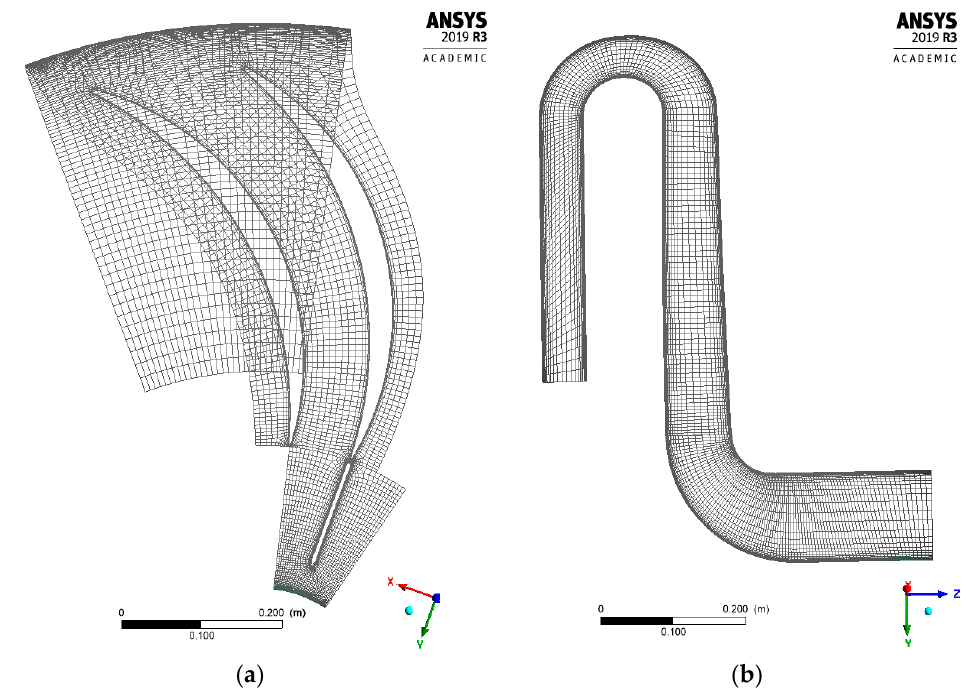
Figure 10. Computational domain in the radial ( a ) and meridional ( b ) planes.